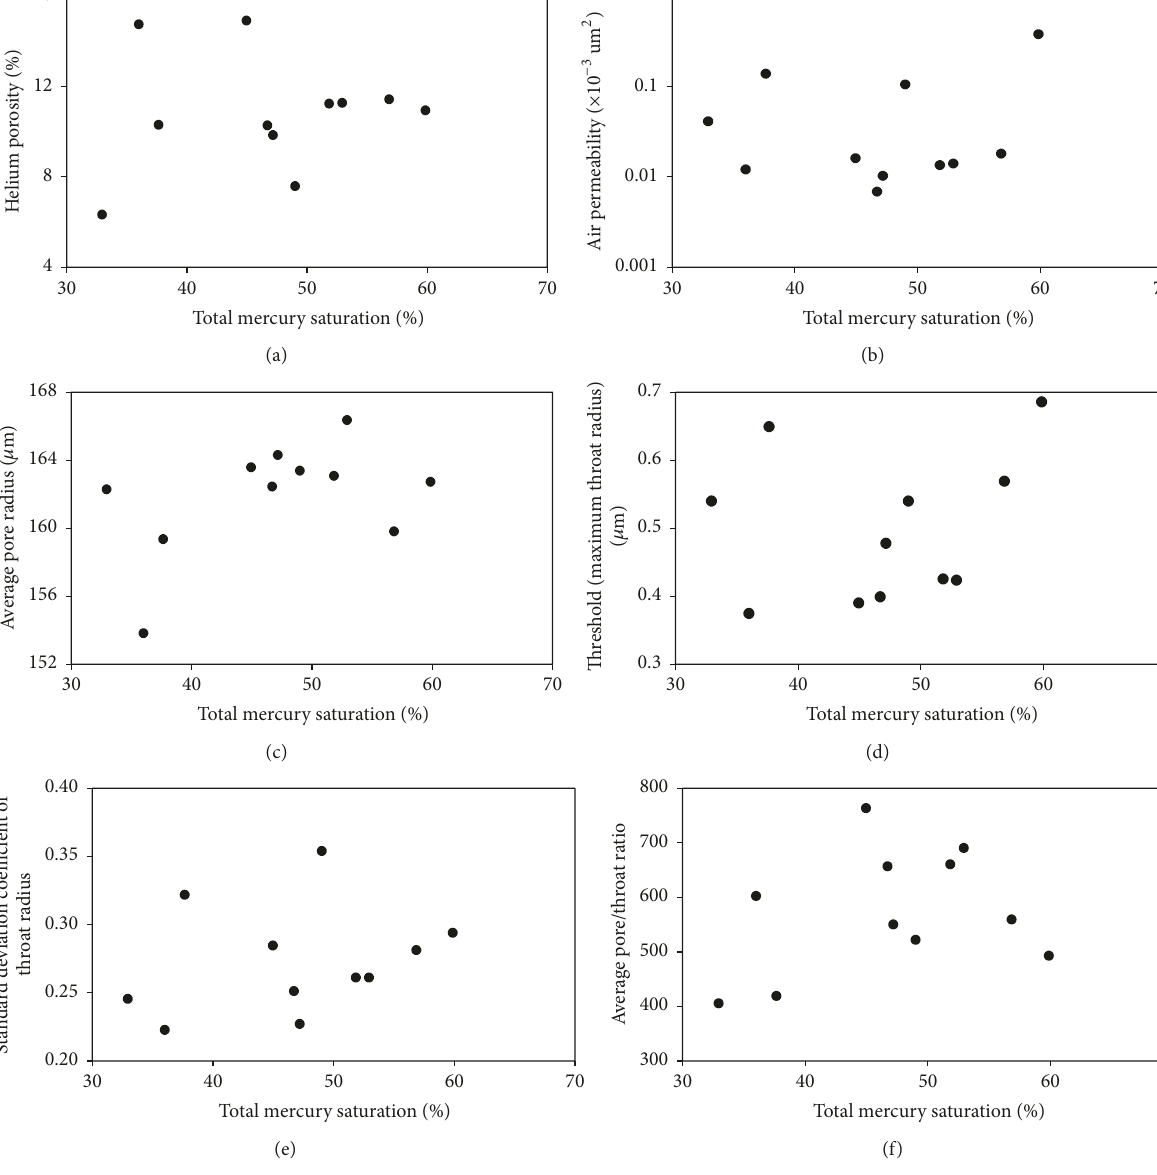
Figure 12: The correlation of pore-throat structure parameters and total mercury saturation of the samples from Upper Triassic Chang 7 Member, Odors